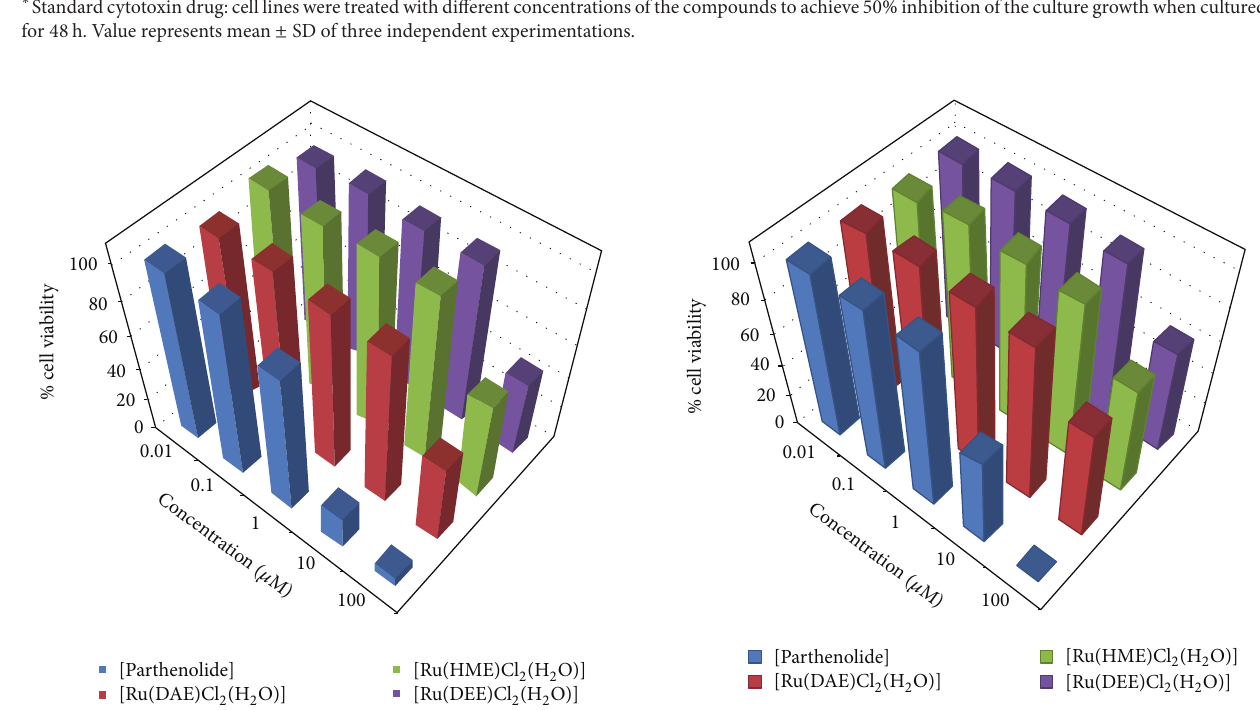
Figure 2: In vitro antiproliferative activity of Ru(III) complexes and parthenolide against human breast cancer cell line (MCF-7).